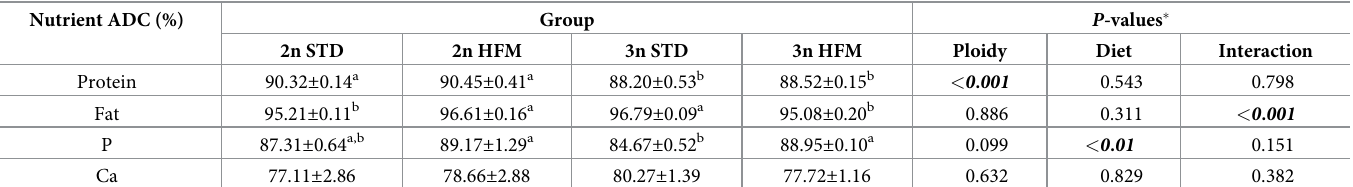
Table 3. Apparent digestibility of